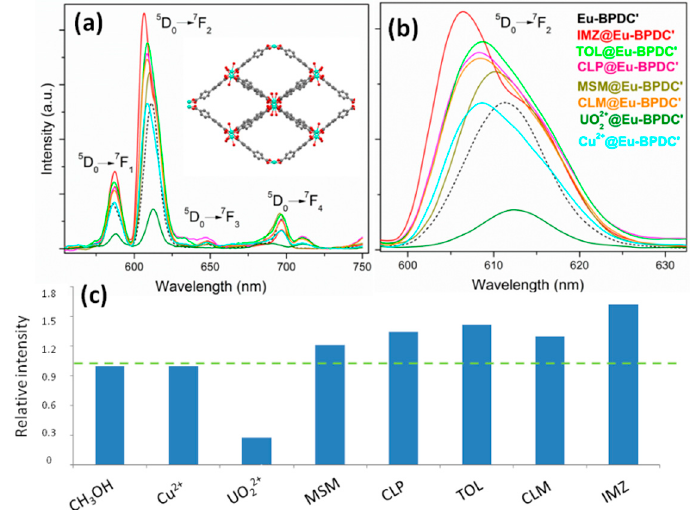
Figure 13. ( a ) Emission spectra of X@Eu-BPDC’ exposed to diverse pollutants (X). ( b ) Zoomed region of the Eu 3+ hypersensitive 5 D 0 → 7 F 2 transition. ( c ) Relative intensities of the hypersensitive signal of Eu-BPDC’ in the presence of diverse pollutants, of X@Eu-BPDC’ ; the dashed green line denotes the system without analyte presence.